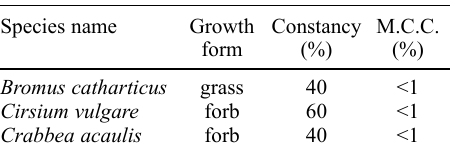
Table 6 Diagnostic species of the Eragrostis plana-Cyperus fastigiatus grassland (M.C.C. - mean canopy